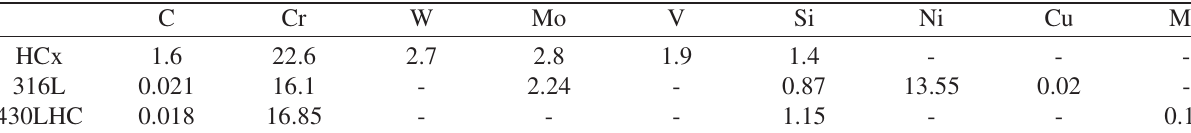
Table 1. Composition of initial materials (% in mass).